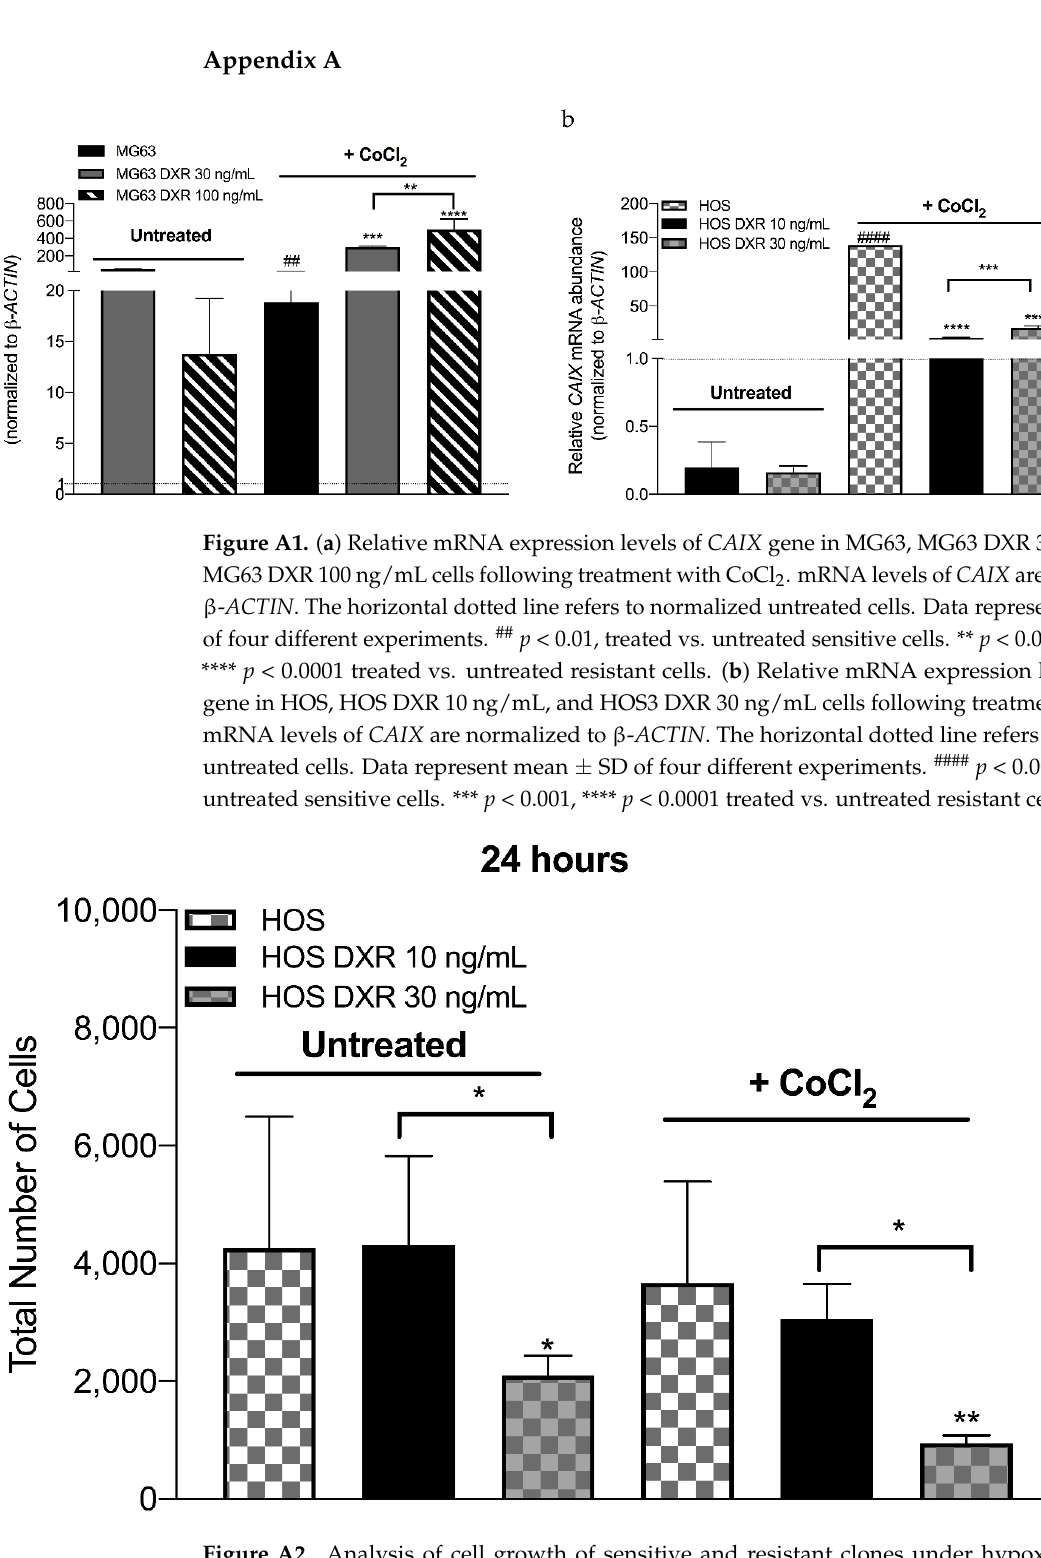
Figure A2. Analysis of cell growth of sensitive and resistant clones under hypoxia for various exposure times. We counted the total number of HOS, HOS DXR 10 ng/mL, and HOS DXR 30 ng/mL cells after CoCl 2 ( a,b ) treatments by Hoechst staining with an automated cell count system and at 24 h. Data represent mean ± SD of four different experiments. * p < 0.05, ** p < 0.01, resistant vs. sensitive clones after CoCl 2 treatment.